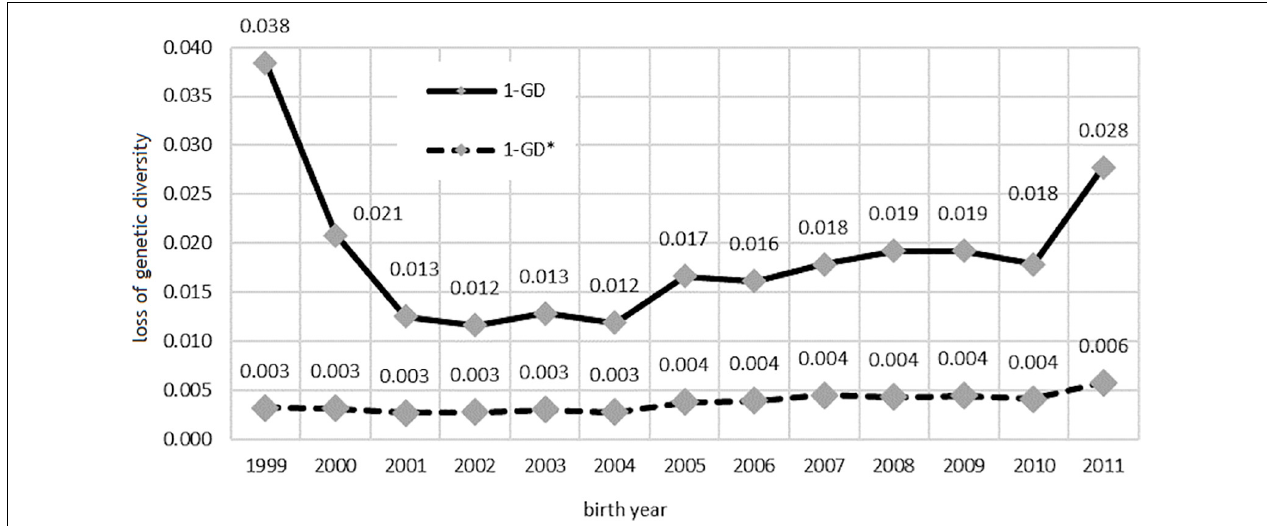
FIGURE 5 | Loss of genetic diversity due to unequal founder contribution, bottlenecks, and genetic drift (1-GD) and only due to unequal founder contribution (1-GD*) in the studied population.